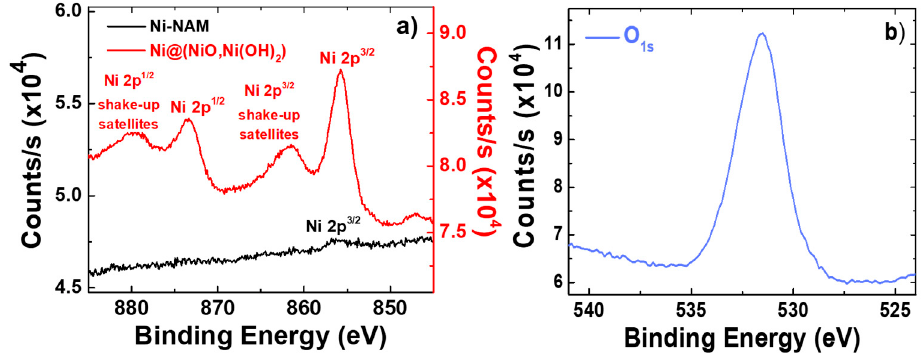
Figure 4. ( a ) XPS analysis of both samples, the former Ni-NAM nanowires (black), and electrochem- ical treated Ni@(NiO, Ni(OH) 2 ) nanowires (red), to the Ni2p core level spectra; ( b ) XPS analysis of